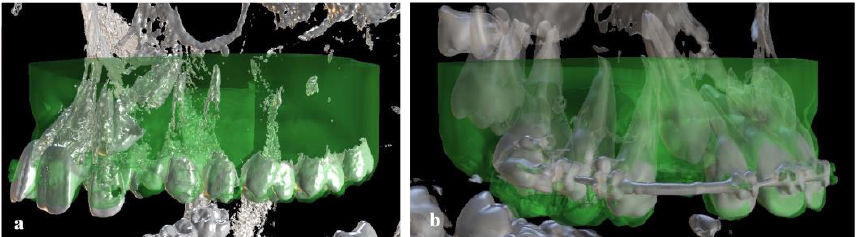
Figure 2. The digital models of the two cases produced by combining DICOM and .STL files (green area). (( a ): patient 1, ( b ): patient